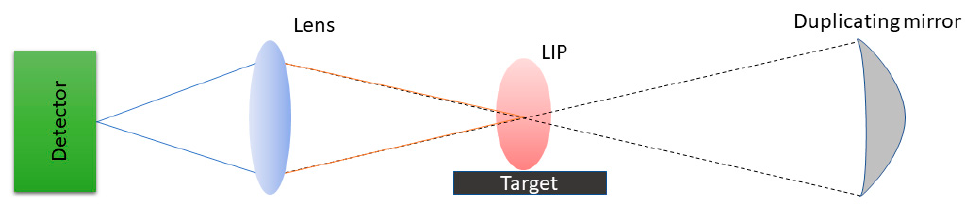
Figure 3. Duplicating mirror scheme.